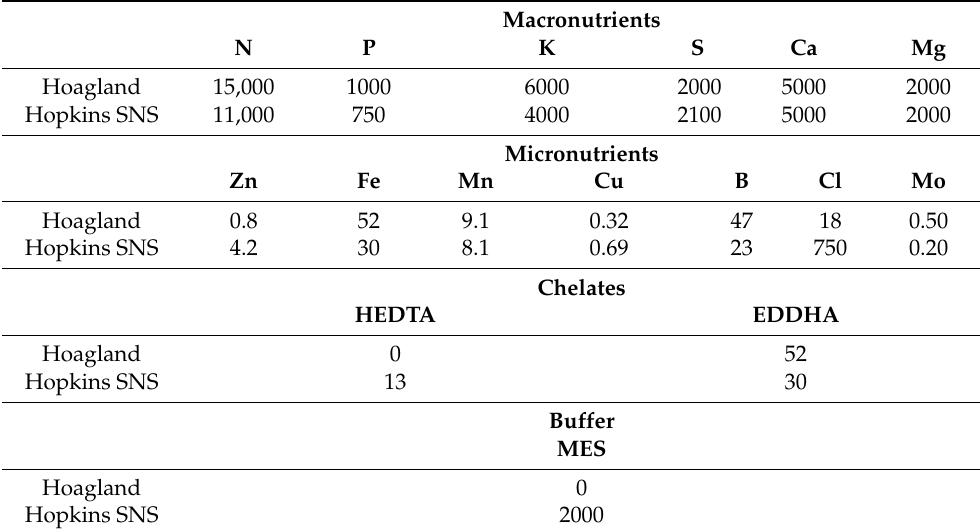
Table 2. Hydroponic nutrient concentrations ( µ M) for the Hoagland solution [10] and Hopkins’ single nutrient source (SNS)